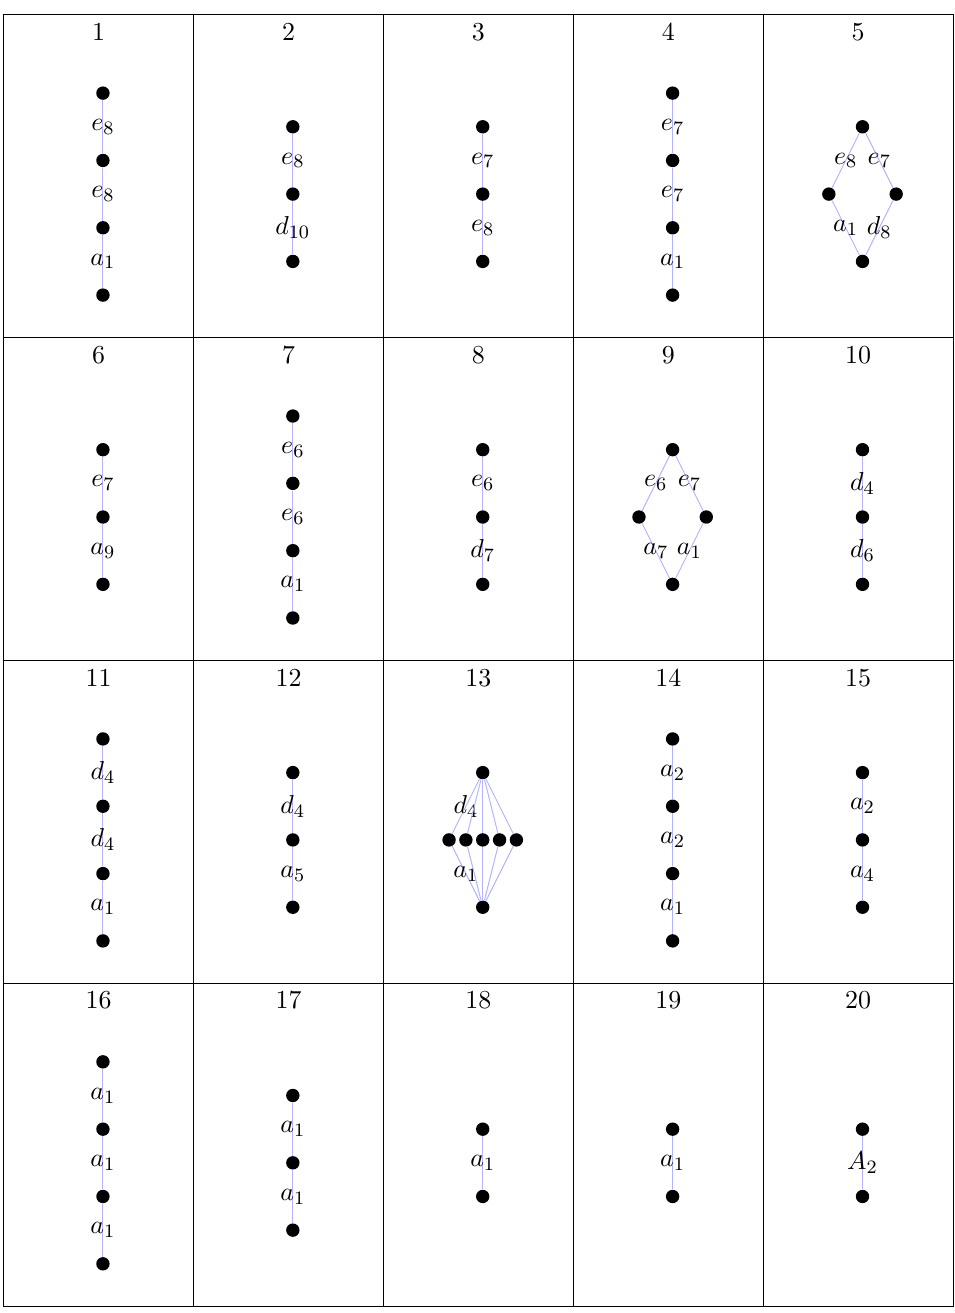
Table 8 . Hasse diagrams deduced from unitary magnetic quivers by quiver subtraction. The color code is explained in the